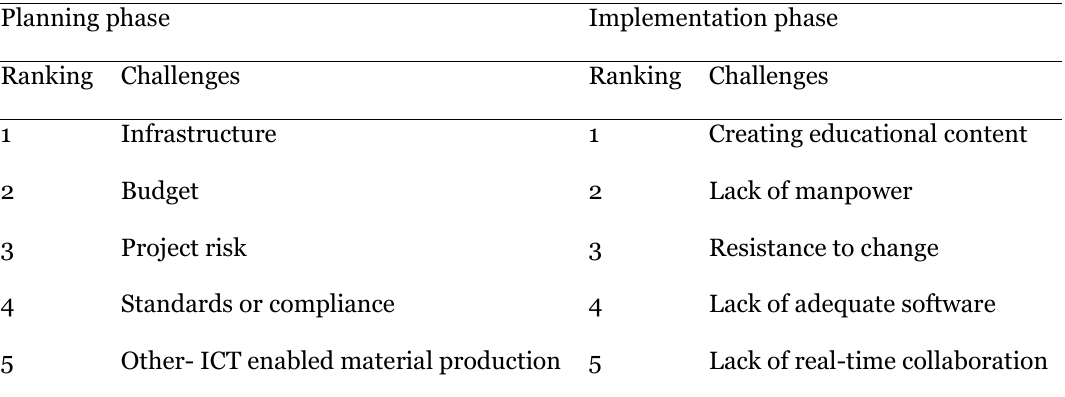
Major Challenges in Planning and Implementation of FOSS Planning